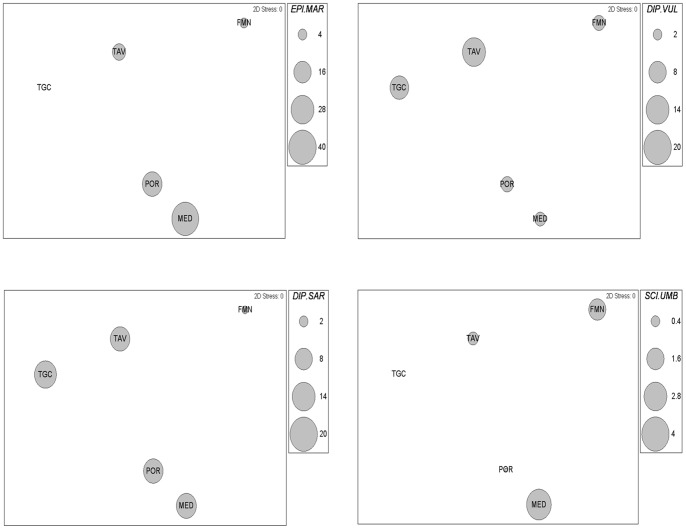
Fish assemblage structures based on biomass data.Two-dimensional nMDS ordinations of centroids of the 5 MPAs classified as HP are shown. Bubble values indicate average biomass of a subset of fish species responding to protection.